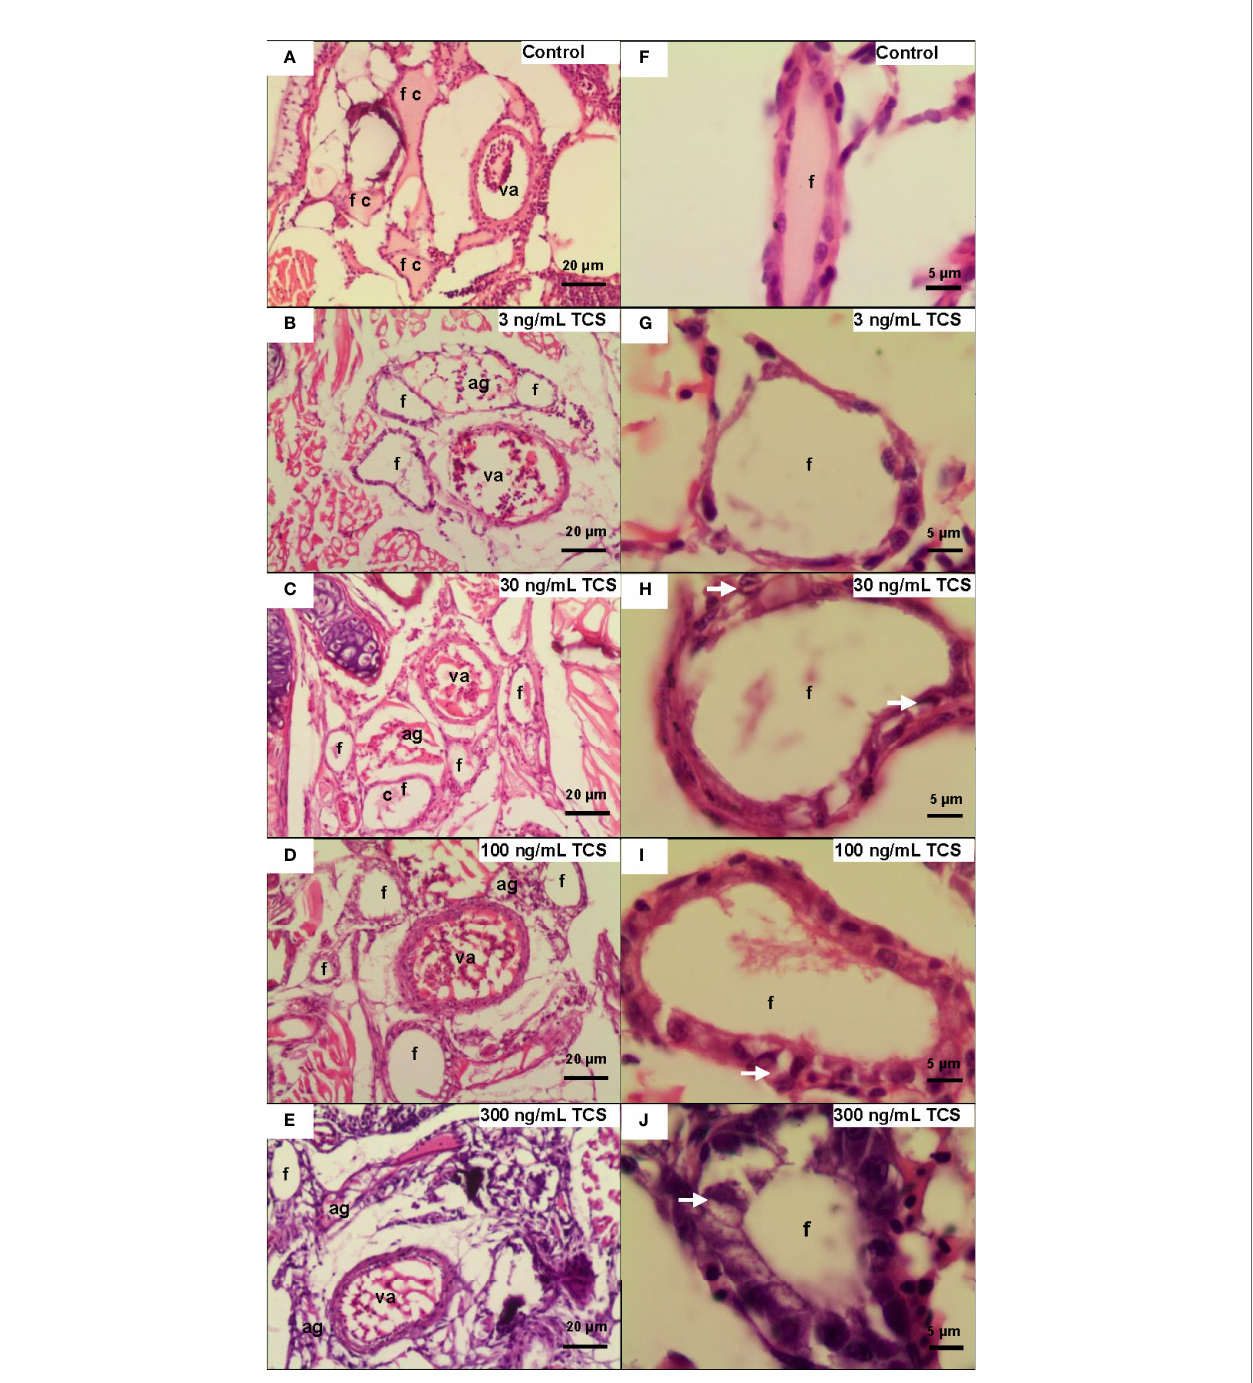
FIGURE 3 | The morphological changes of thyroid follicles in different TCS concentration groups. (A) In the control group, the zebra fi sh follicle squamous to cuboidal follicular epithelium, with colloid in follicle at 400× and 1000× (F) . (B – E) Follicle hyperplasia with decreased colloid in the lumen and angiogenesis in TCS 3, 30, 100, and 300 ng/mL exposure at 400×. (G – J) Hypertrophy and hyperplasia offollicle cells in TCS 3, 30, 100, and 300 ng/mL exposure at 1000×. (va = ventral aorta; c = colloid; f = thyroid follicle; ag = angiogenesis; white arrows =